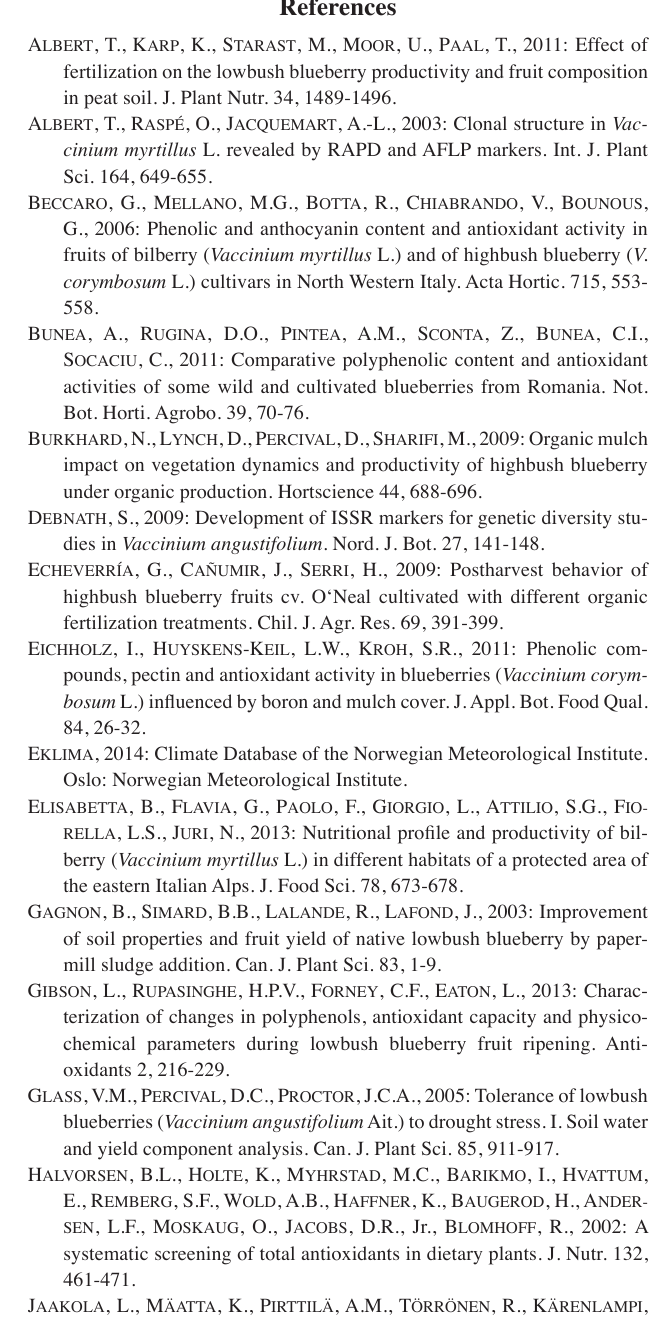
Supplementary Tab. S1. Overview of soil characteristics of all trial fields. Supplementary Tab. S2. Pearson correlation analysis of cli- mate (annual data) and soil factors (2009) with berry quality meas-